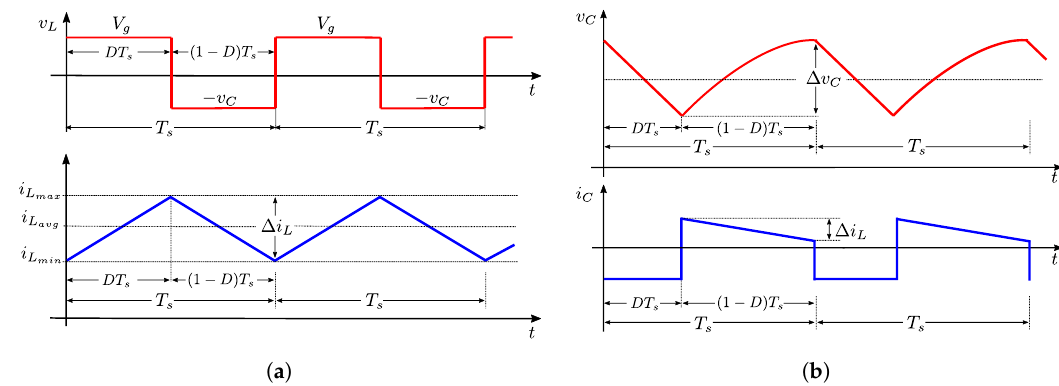
Figure 7. Stationary waveforms of inductors and capacitors: ( a ) Inductor waveforms; ( b ) Capacitor waveforms.